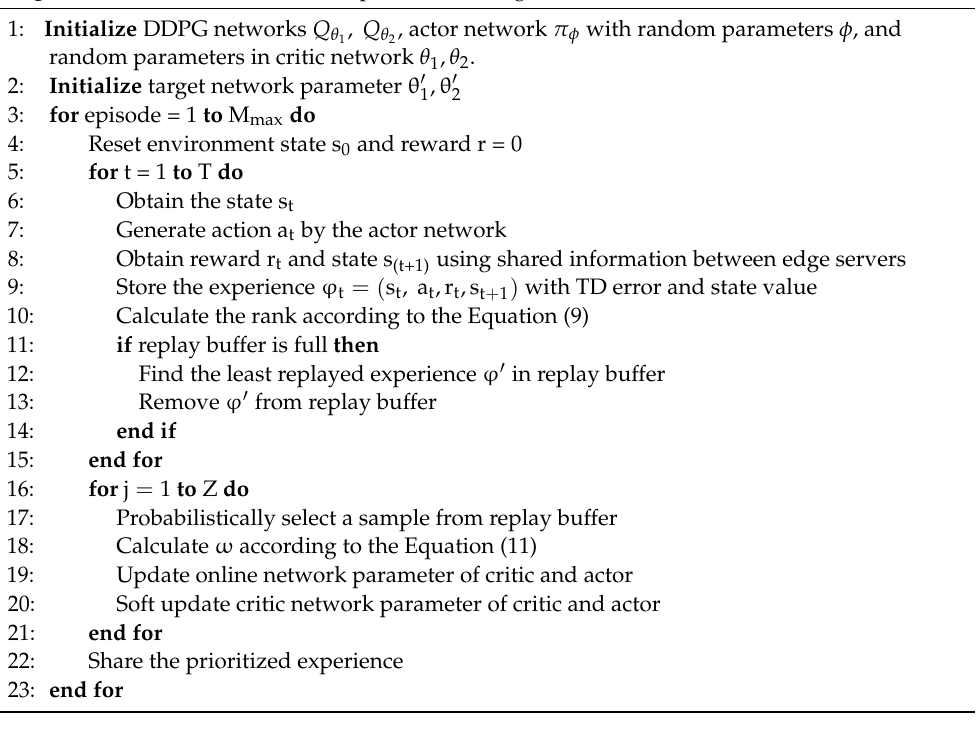
Algorithm 1 RL with Prioritized Experience